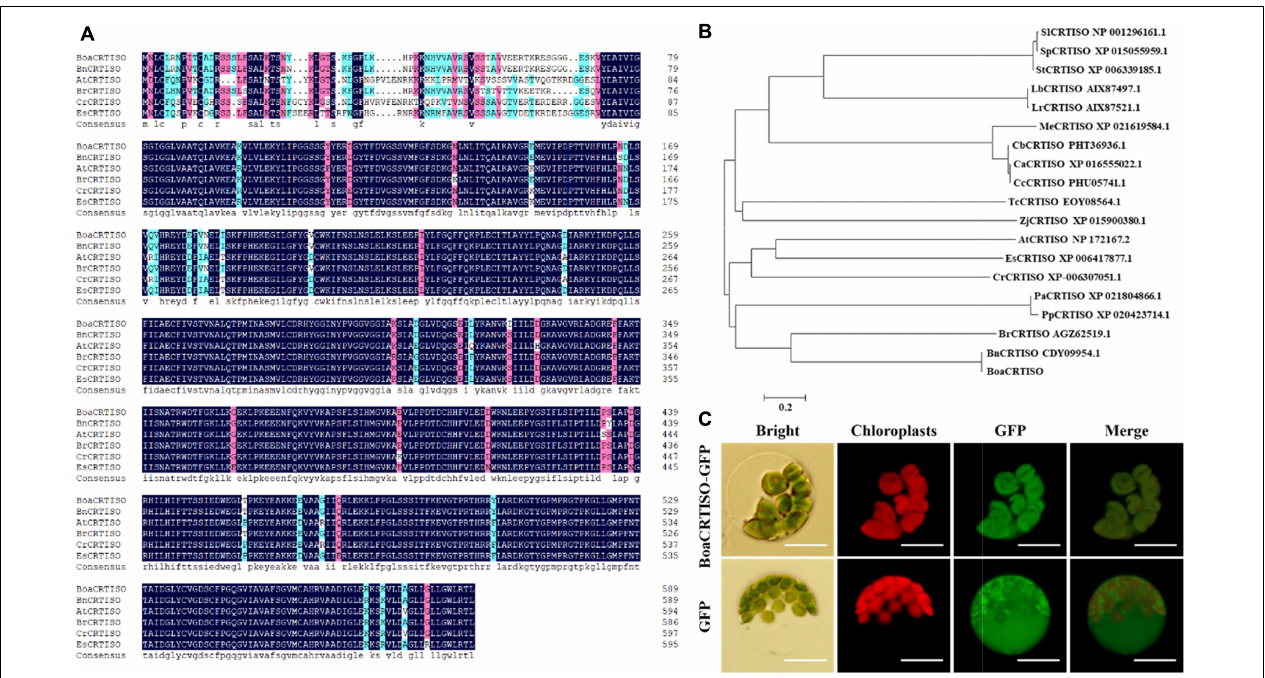
FIGURE 1 | Sequence characteristics of BoaCRTISO. (A) Alignment of the protein sequence of BoaCRTISO with selected homologs. The alignment was performed using DNAMAN software. The amino acids with 100% identity are shown with a black background, those with ≥ 75% identity are shown in red, and those with ≥ 50% identity are shown in blue. The species and their accession numbers in GenBank [ Brassica napus (Bn): BnCRTISO (CDY09954.1), Brassica rapa (Br): BrCRTISO (AGZ62519.1), Arabidopsis thaliana (At): AtCRTISO (NP_172167.2), Capsella rubella (Cr): CrCRTISO (XP_006307051.1), and Eutrema salsugineum (Es): EsCRTISO (XP_006417877.1)] are listed here. (B) Phylogenetic analysis of BoaCRTISO and selected CRTISO from other plant species. The phylogenetic tree was generated using the neighbor-joining method by MEGA 6.0 software. The bar indicates an evolutionary distance of 0.2%. The species [ B. napus (Bn), B. rapa